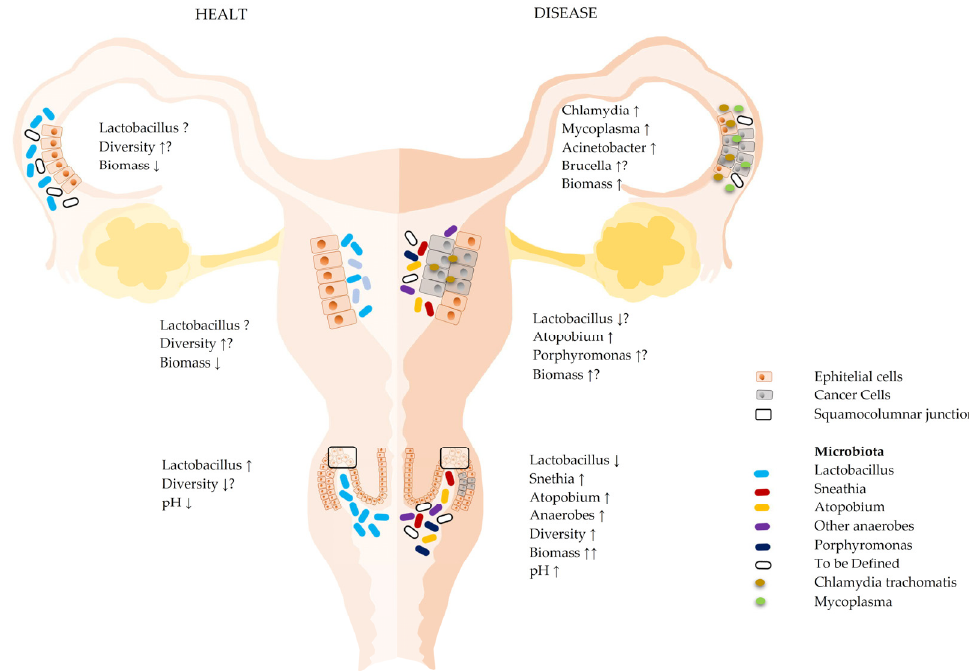
Figure 1. Microbial communities at various levels of the reproductive system and their variation with healthy and diseased states. Microbial composition and other characteristics of the microenvironment in healthy and pathological states in the various areas of the female reproductive system (FRT). Healthy vaginal microbiotas are mainly composed of low microbial biodiversity and are dominated by lactobacilli. In contrast, the biomass of the upper reproductive system (endometrium, tubal, and ovary) may have a much lower biomass and a higher biodiversity than the cervical microbiota, with a lactobacillary share that decreases further inside the reproductive system. In pathological conditions, the composition and biomass of the microbiota from the entire reproductive system change considerably (see text) [4]. The arrows represent increase or decrease depending on the orientation, the question marks indicate that the issues are still to be definitively clarified.